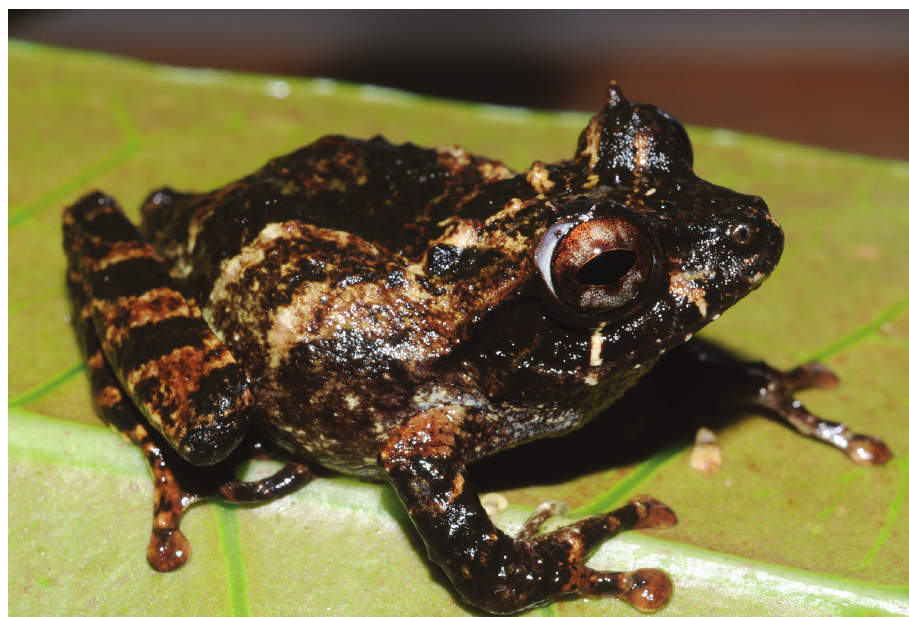
Figure 32. Philautus surdus male from May-Impit, Mt. Hilong-hilong, Municipality of Remedios T. Romualdez, Agusan del Norte Province. Photo: